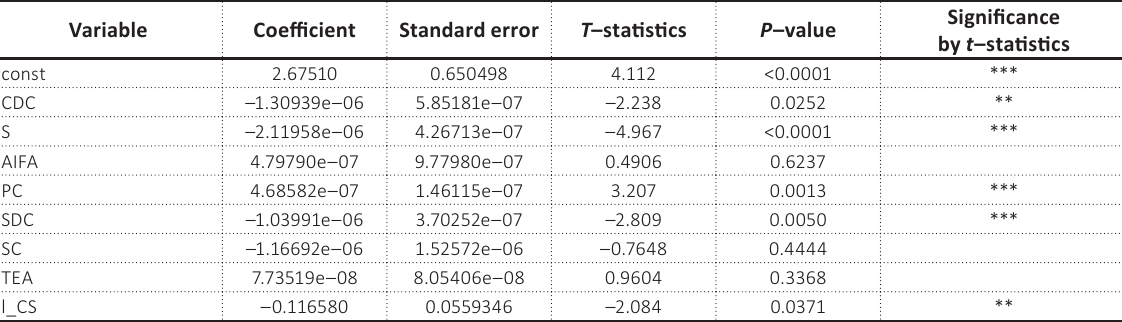
Source: Calculated via Gretl software package.